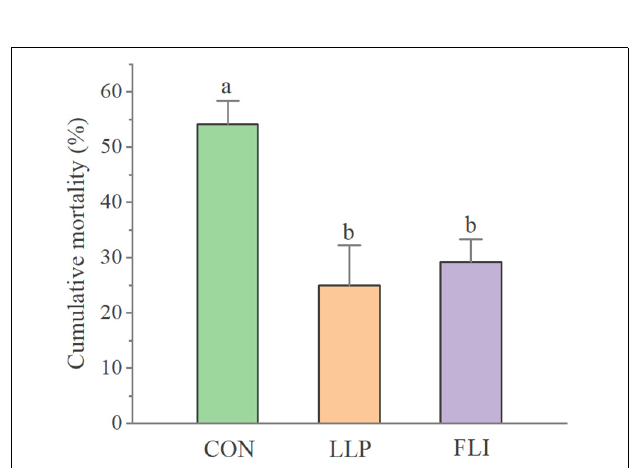
FIGURE 8 | Cumulative mortality of P.